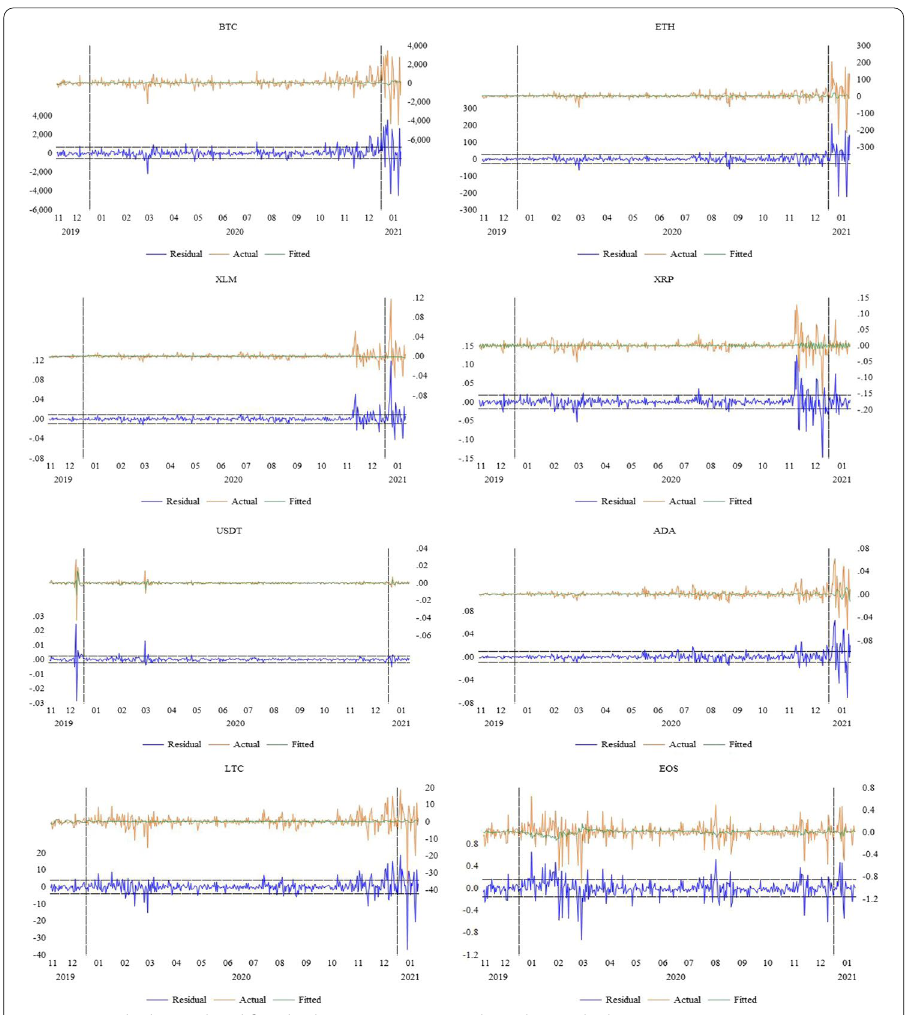
Fig. 13 Residual, actual and fitted values. Source : CoinDesk, Authors’